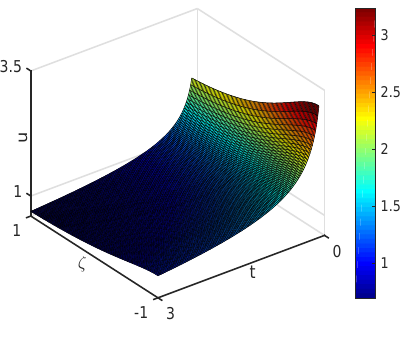
Figure 5: The graph of u ( x , t ) given by Eq. (4.3) and Eq. (4.4) .